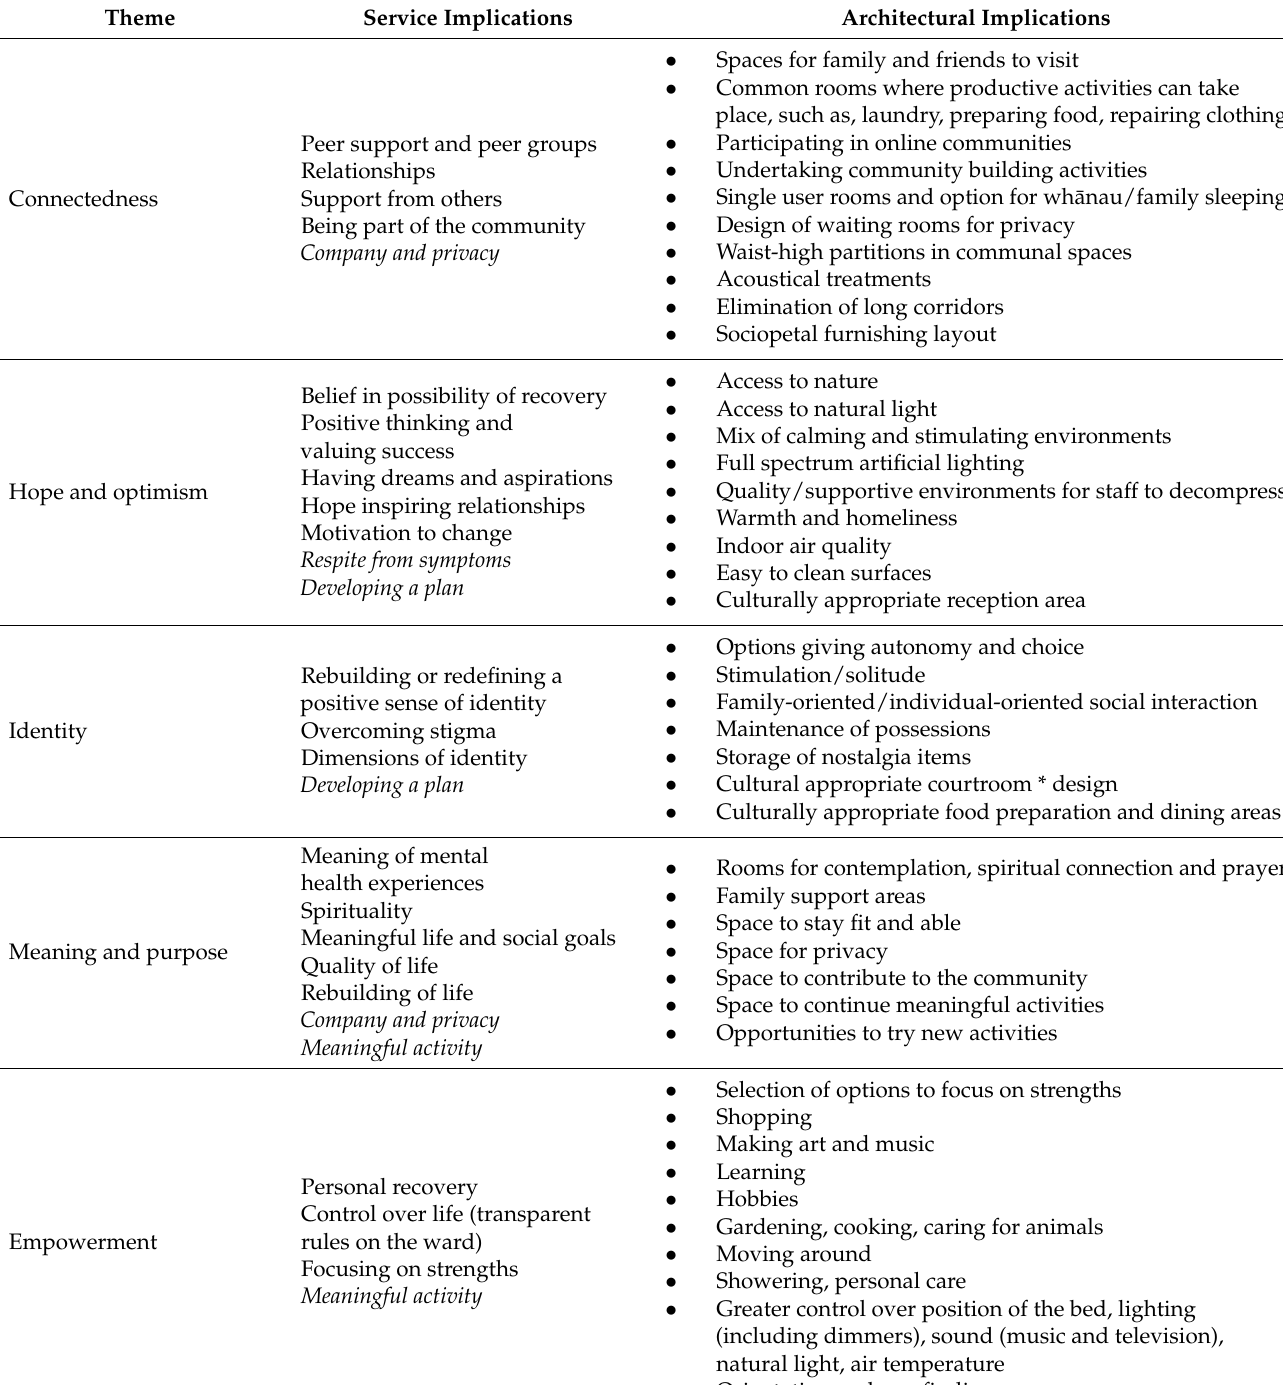
Table 5. The list of needs that the facility design must accommodate [7], Bird et al. (2014) modified by the authors for